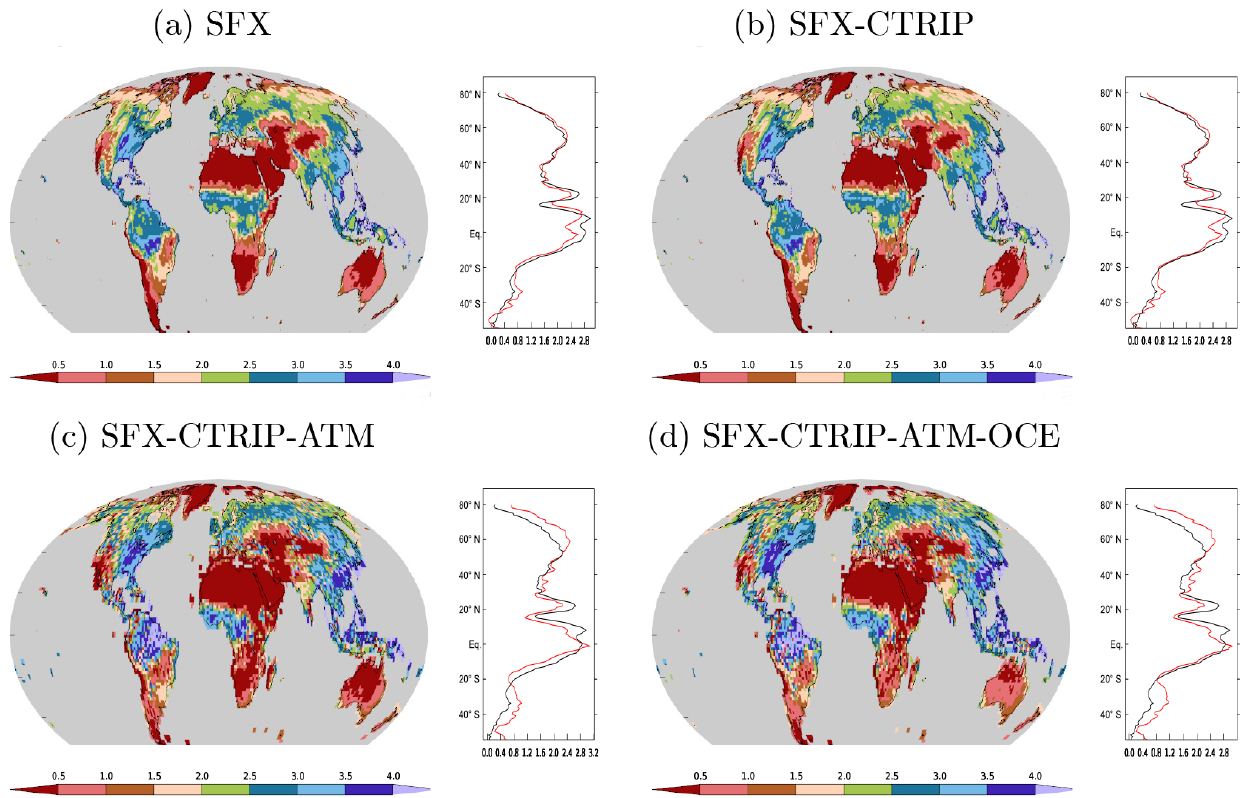
Figure 3. JJA mean land surface evaporation averaged over the period 1980–2009. In the zonal mean plot, the black line represents observa- tionally derived data from Jung et al. (2009) averaged over 1982–2008, the red line the